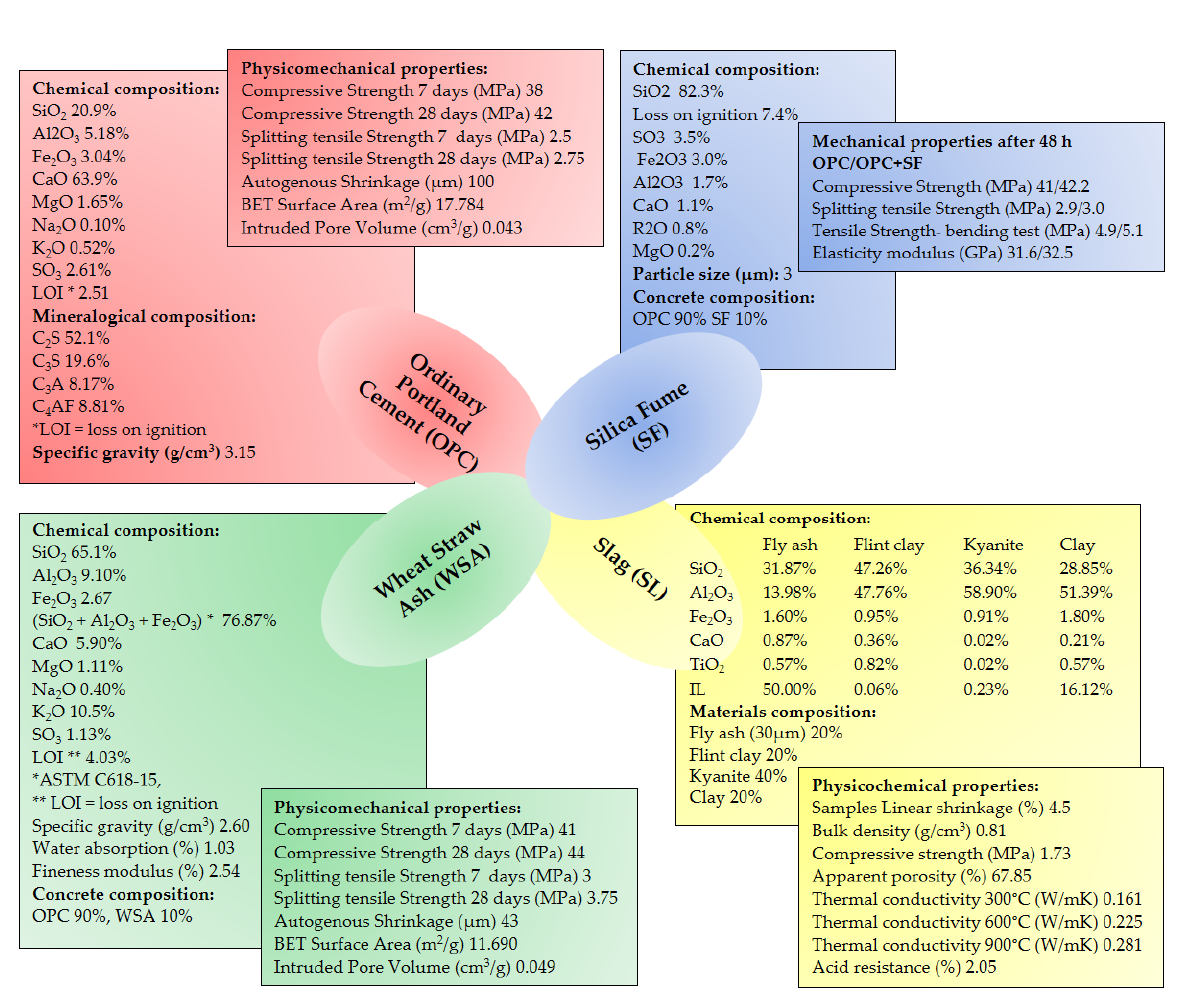
Figure 3. Diagram presenting the properties of silica fume, slag, and WSA compared with ordinary Portland cement based on the literature.